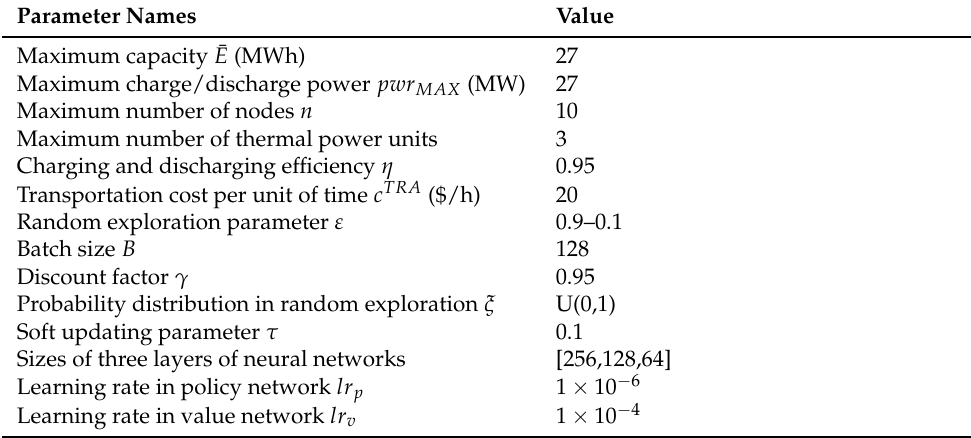
Table 2. Experiment